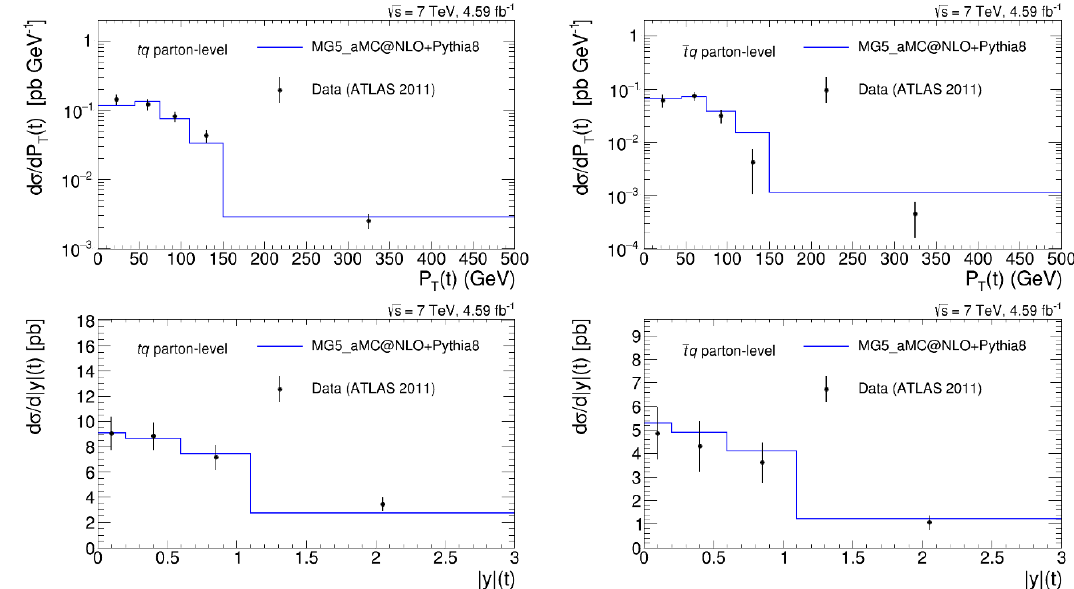
Figure 2 . Absolute di(cid:11)erential single top (left) and anti-top (right) quark cross sections at parton level as a function of the top p T (upper row) and top j y j (lower row). Data are taken from ref.